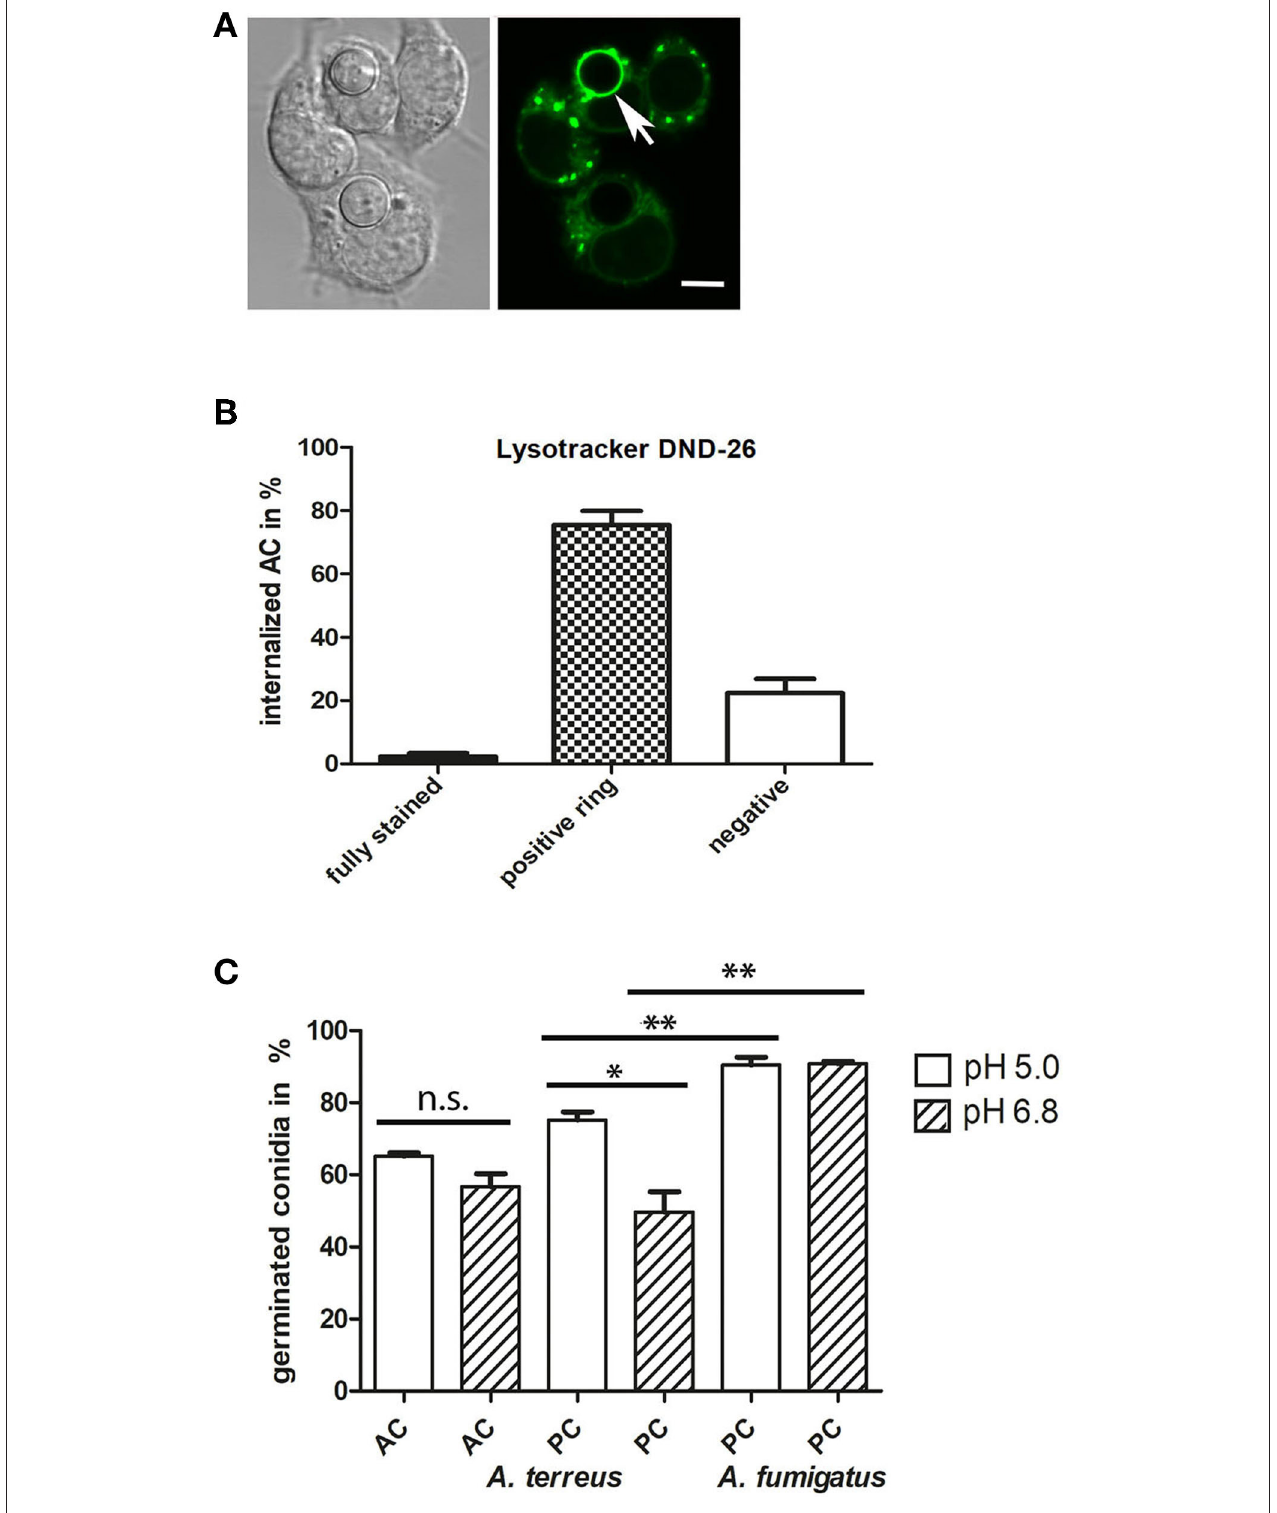
FIGURE 9 | Internalized AC reside in acidified vacuoles. J774 cells were infected with one AC per two J774 cells. After 6h of infection, LysoTracker DND-26-stained samples were analyzed by live-cell microscopy. A representative image is shown in (A) ; an AC within an acidified vacuole is indicated by an arrow. The bar represents 5 µ m. (B) shows a quantitative evaluation of AC that were either directly stained by the LysoTracker (fully stained), resided in acidified vacuoles (positive ring), or were